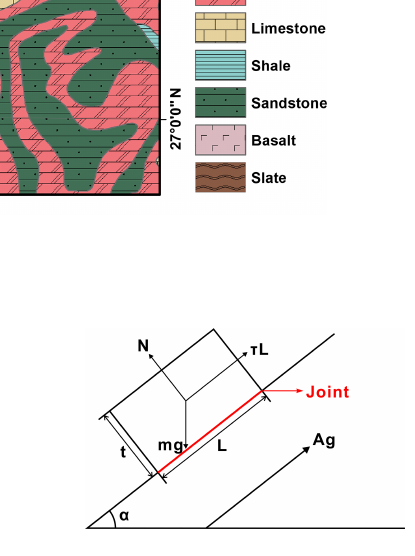
Figure 3. Conceptual sliding-block model of Newmark